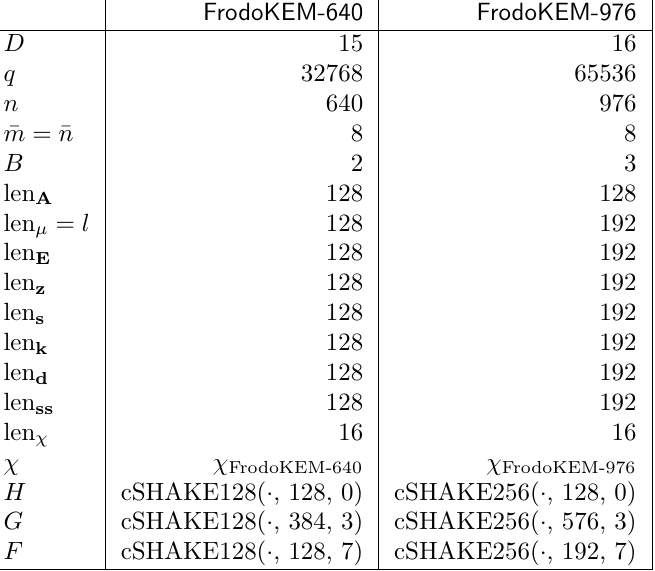
Table 1: Implemented FrodoKEM parameter sets.